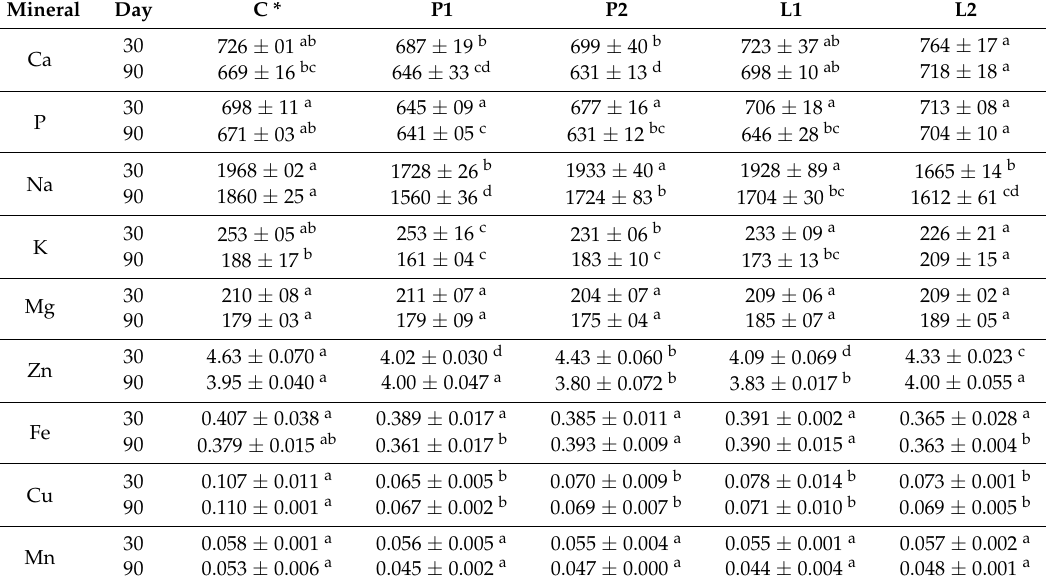
Table 6. Mineral contents (mg 100g − 1 ) of experimental White cheeses during ripening ( n = 3).